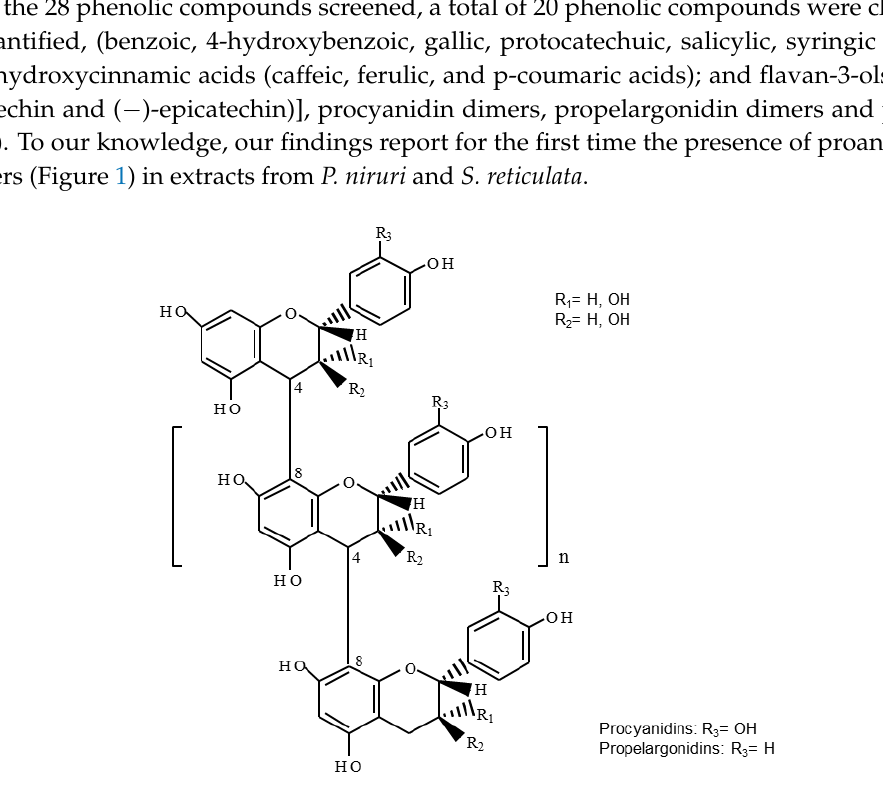
Figure 1. General chemical structure of B-type proanthocyanidins: procyanidins (composed by (epi) catechin units) and propelargonidins (composed by (epi) afzelechin